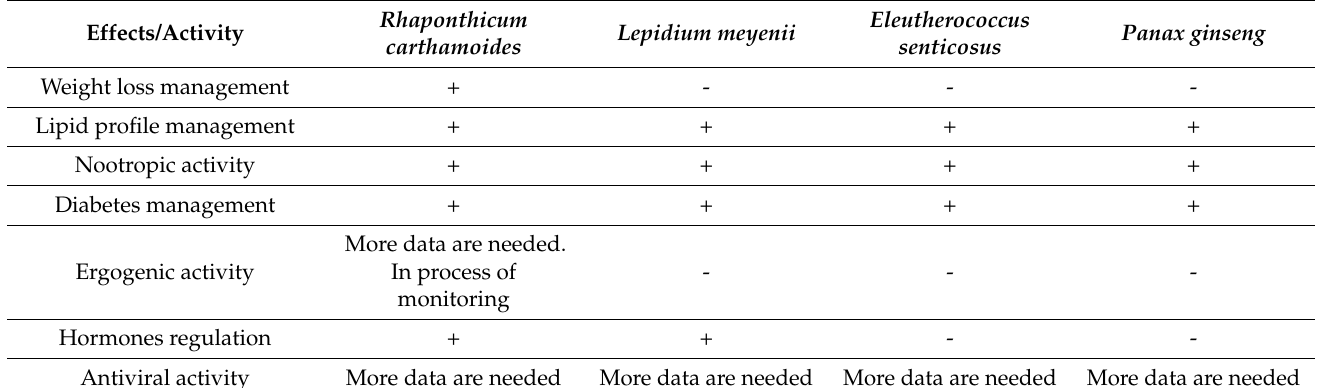
Table 7. Effects and future perspectives of extracts/ bioactive